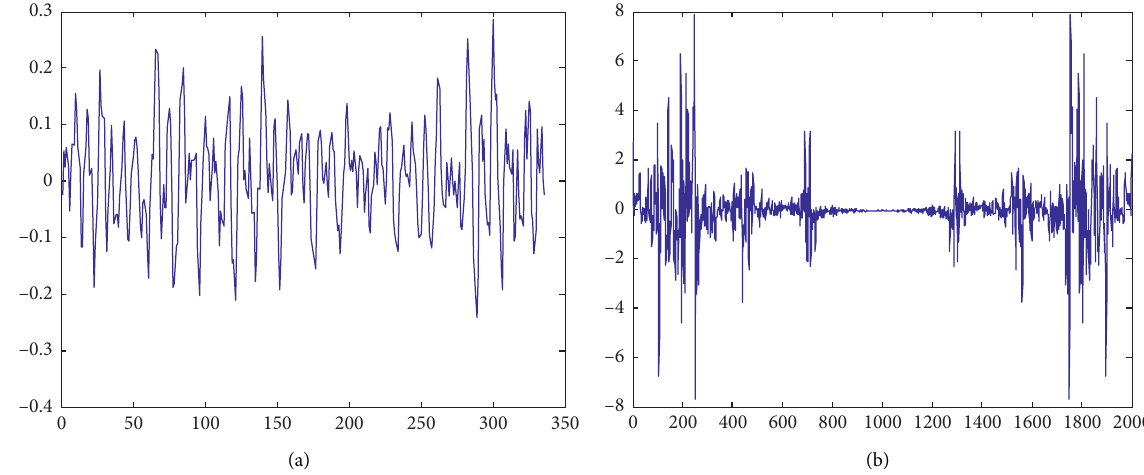
Figure 12: Partial time-domain data (a) and spectrum analysis (b) of fault 4.